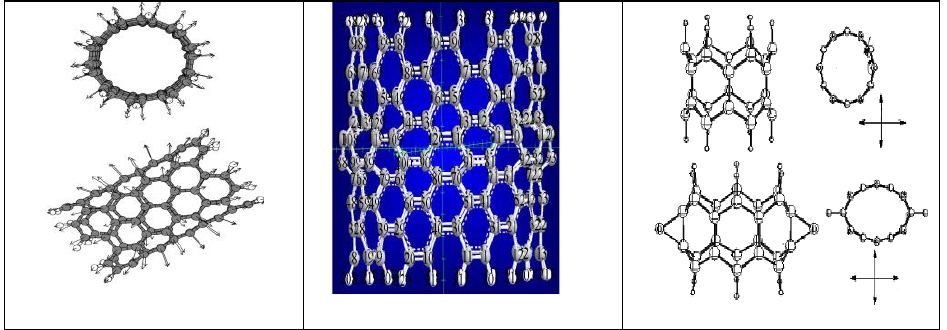
Fig.2: Structure deformation of a SWCNT as caused by its vibration motion.